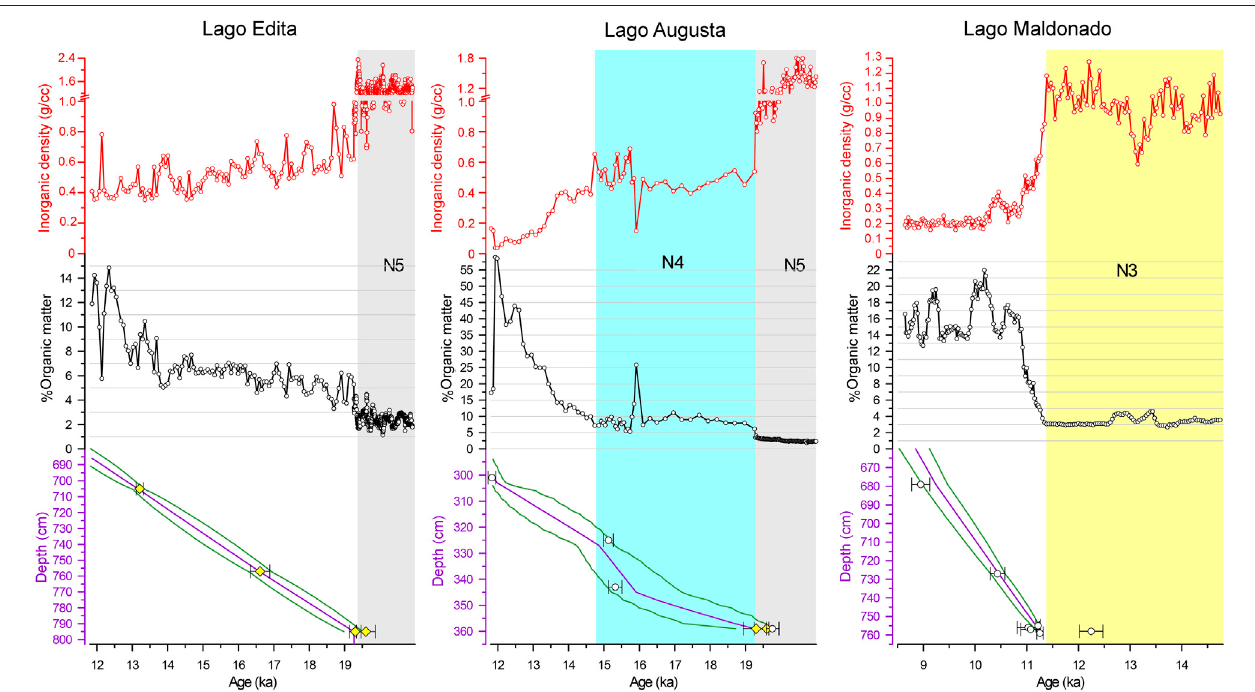
FIGURE 10 | Inorganic density, organic percentage, and age model from the Lago Edita, Lago Augusta, and Lago Maldonado records. The magenta line (lower panel) represents the median probability of the interpolated age, the green lines indicate the 95% con fi dence interval. The white circles in the lower panels indicate the median probability of the calibrated age for each radiocarbon date, the black horizontalbars represent the 95% con fi dence interval for each calibrated date. The yellow- fi lleddiamondsrepresentthecalibratedradiocarbondatesfromLagoEdita.NoticethattheagemodelfromLagoAugustaincludesan in-situ obtainedradiocarbon date and the correlated basal radiocarbon dates from Lago Edita. The time intervals N5, N4, and N3 are shown as shaded rectangles.